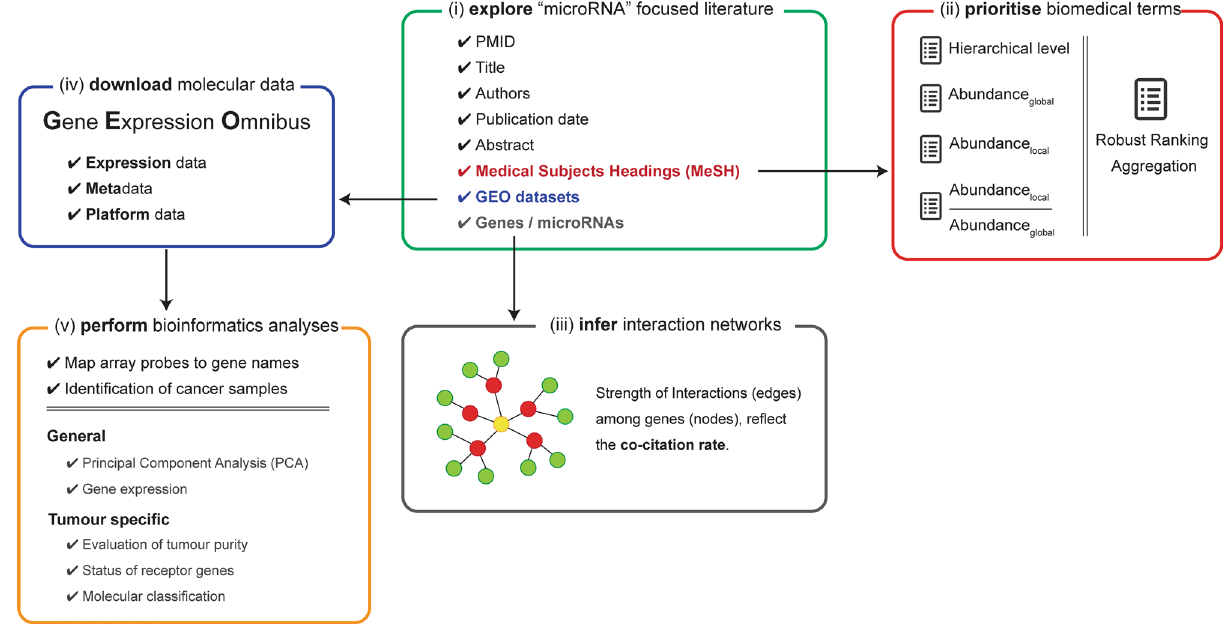
Figure 1. Overview of MAP update